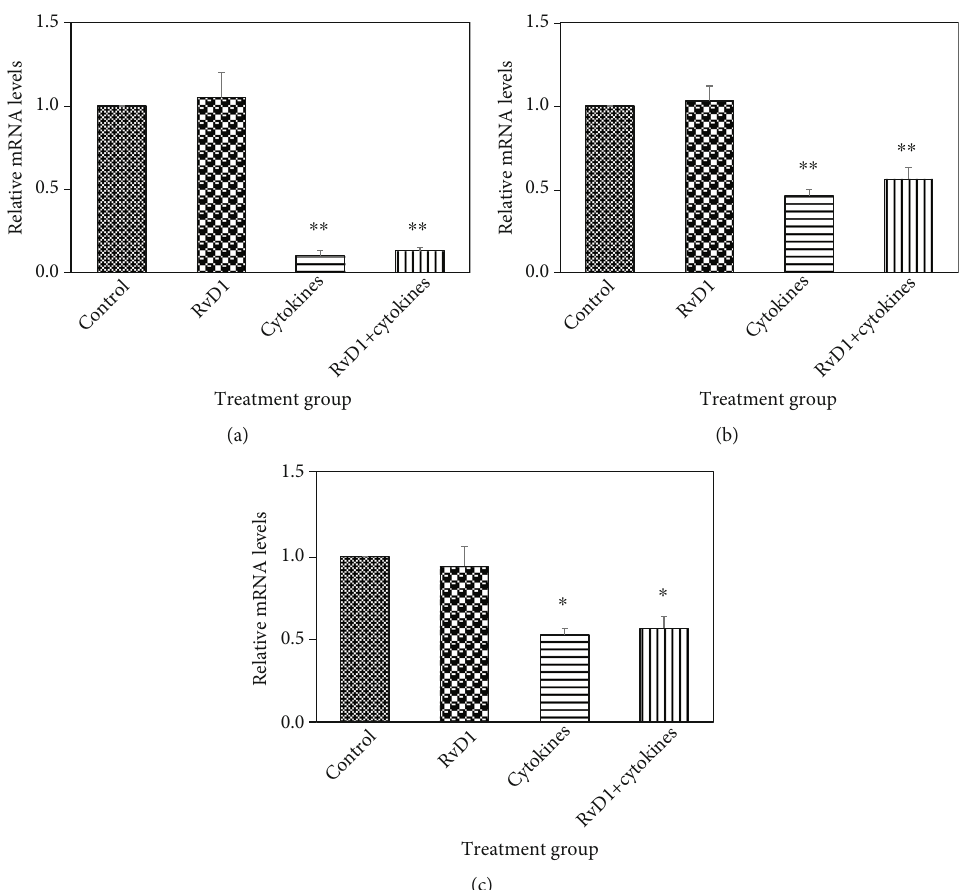
Figure 2: The e ff ects of RvD1 and T 1 cytokines on mRNA levels of genes involved in arginine metabolism in DHLF. ARG2 (a), ODC (b), H and OAT (c) mRNA levels were determined in DHLF. DHLF were treated with 1 μ M RvD1, T 1 cytokine cocktail (25 ng/mL TNF- α , 10 ng/ H mL IFN- γ , and 100 ng/mL IL- 1 β ), or both for 24 hours. RNA was then extracted from DHLF and analyzed by RT-qPCR. Data